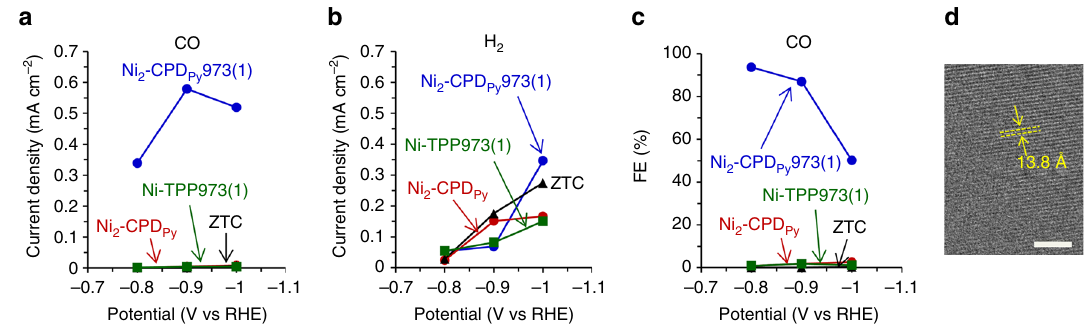
Fig. 6 Examination of selective CO 2 electro-reduction into CO. a , b Partial current densities used for ( a ) CO and ( b ) H 2 generation on the samples